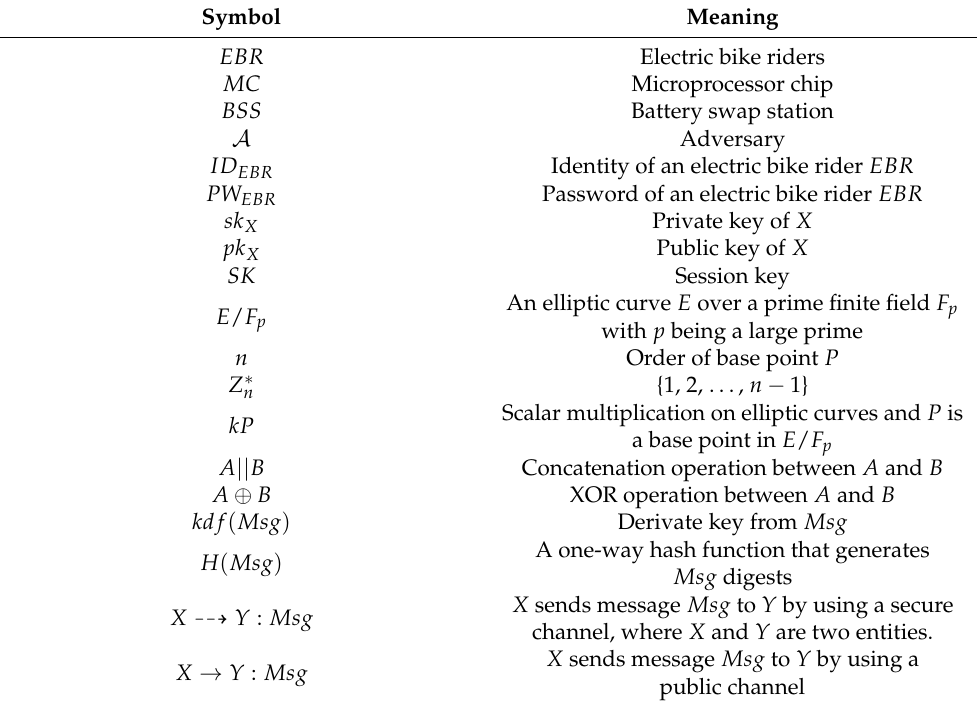
Table 2. Symbols used in